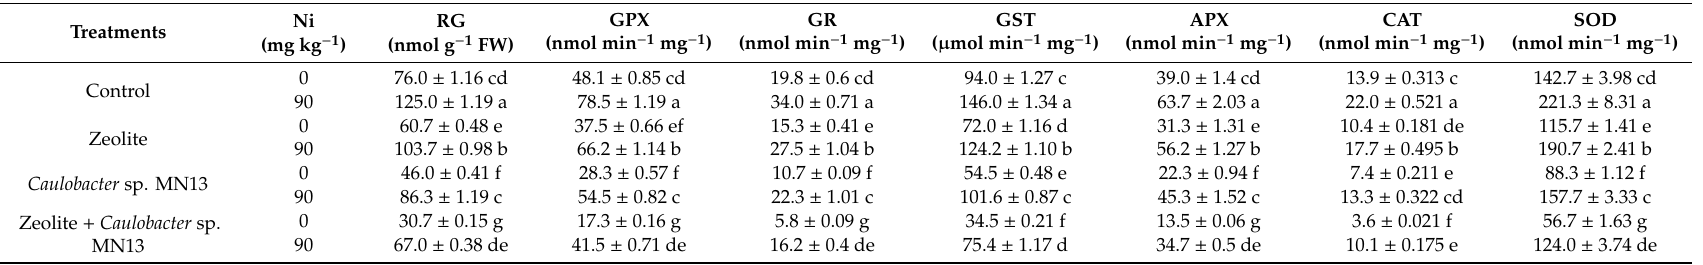
Table 4. E ff ect of Caulobacter sp. MN13 and zeolite on antioxidant assays of sesame plant in normal and Ni contaminated soil.